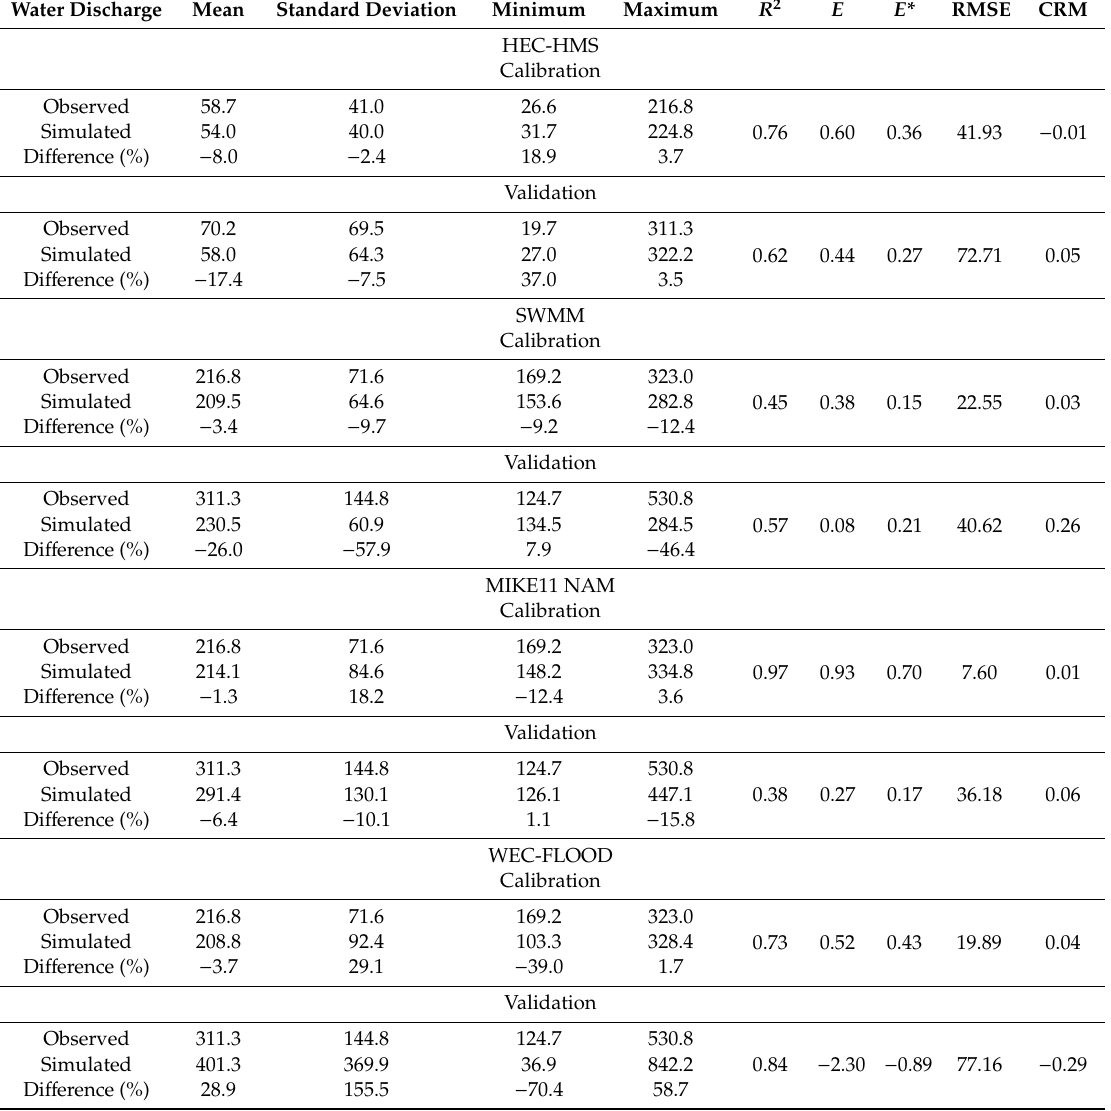
Table 3. Statistics and indexes for evaluating the discharge (in m 3 / s) prediction capability of four hydrological models in the Mesima torrent (Calabria, Southern